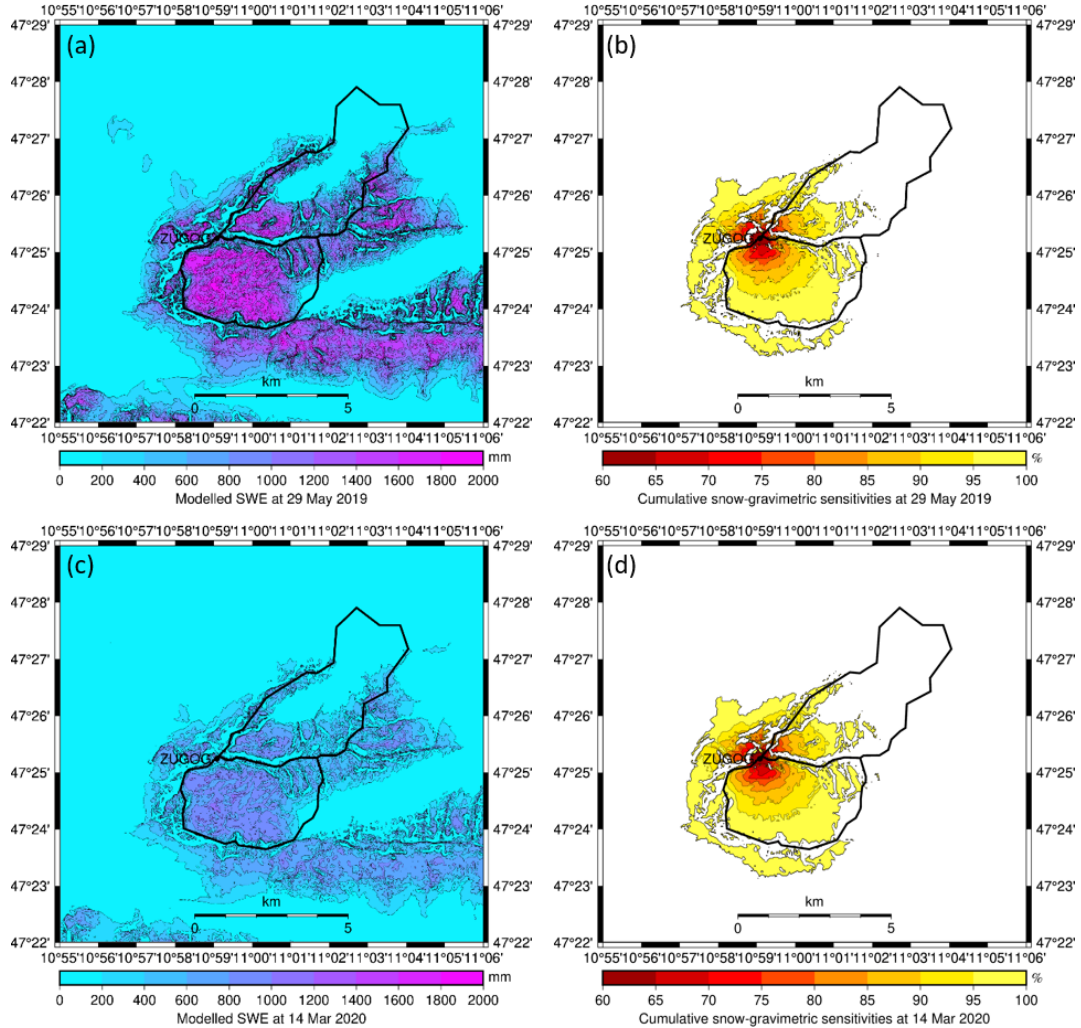
Figure 5. Assumed SWE of the snowpack at maximum seasonal gravity residuals (a, c) and corresponding cumulative snow–gravimetric sensitivities (b, d) with regard to ZUGOG at 29 May 2019 and 14 March 2020, respectively. The boundaries of the Partnach spring and Hammersbach catchments are shown as a black line. Sensitivities are shown only up to 99.87% and 99.76%, respectively, for the given examples, omitting residuals of 1nms − 2 of the total signal.